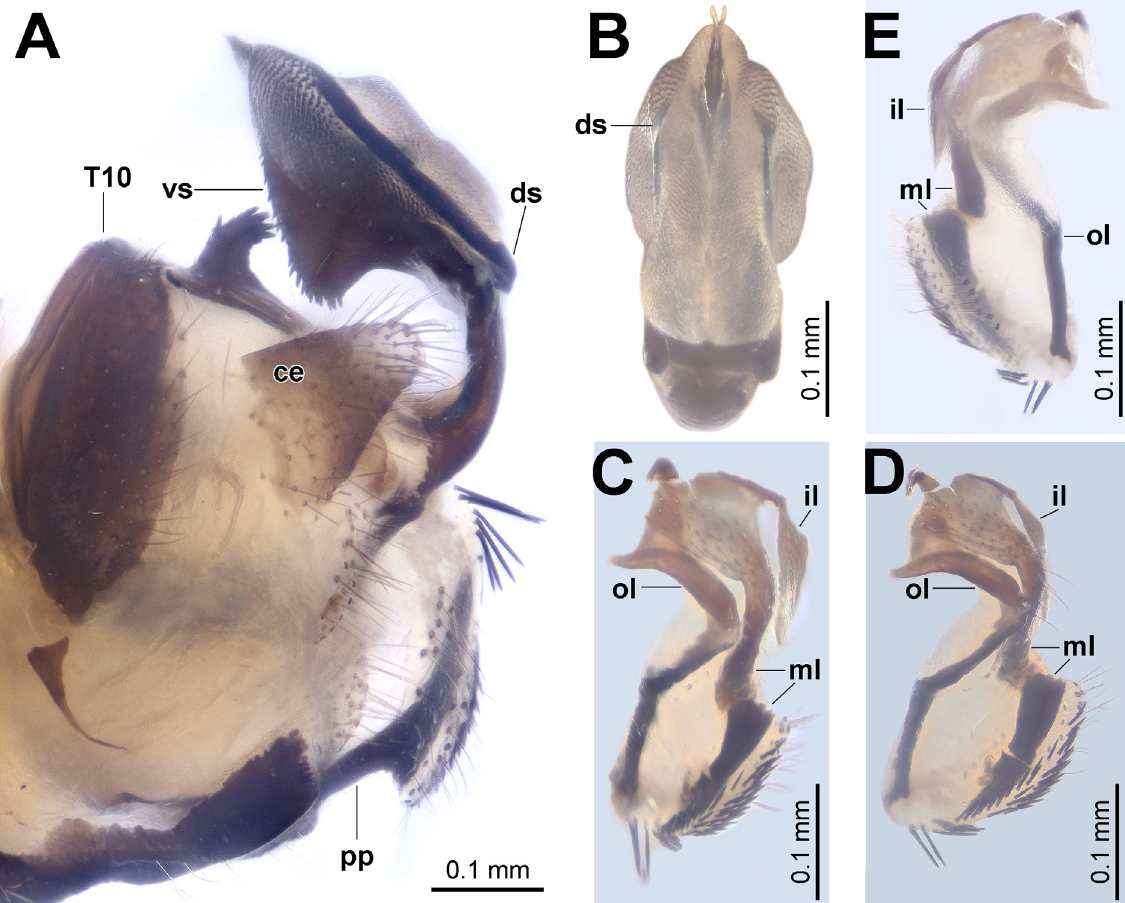
Fig. 10. Amphinemura jiaoheensis sp. nov. A . Male tergum 10 and epiproct, lateral view. B . Male epiproct, dorsal view. C . Male paraproct, dorsal view. D . Male paraproct, dorsolateral view. E . Male paraproct, ventral